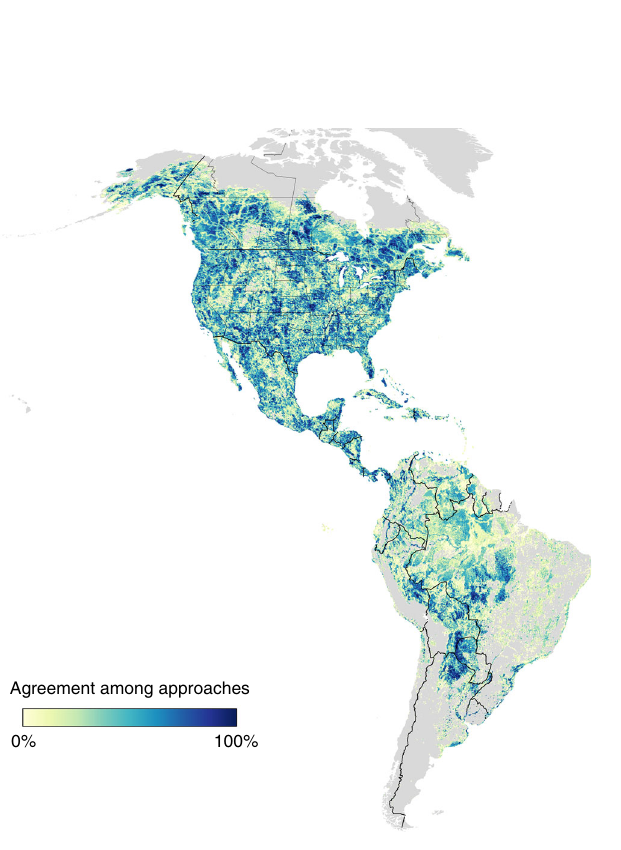
Table 2 Area selected (1000 km^2) for major land cover types Land cover Area Cropland/mosaic cropland